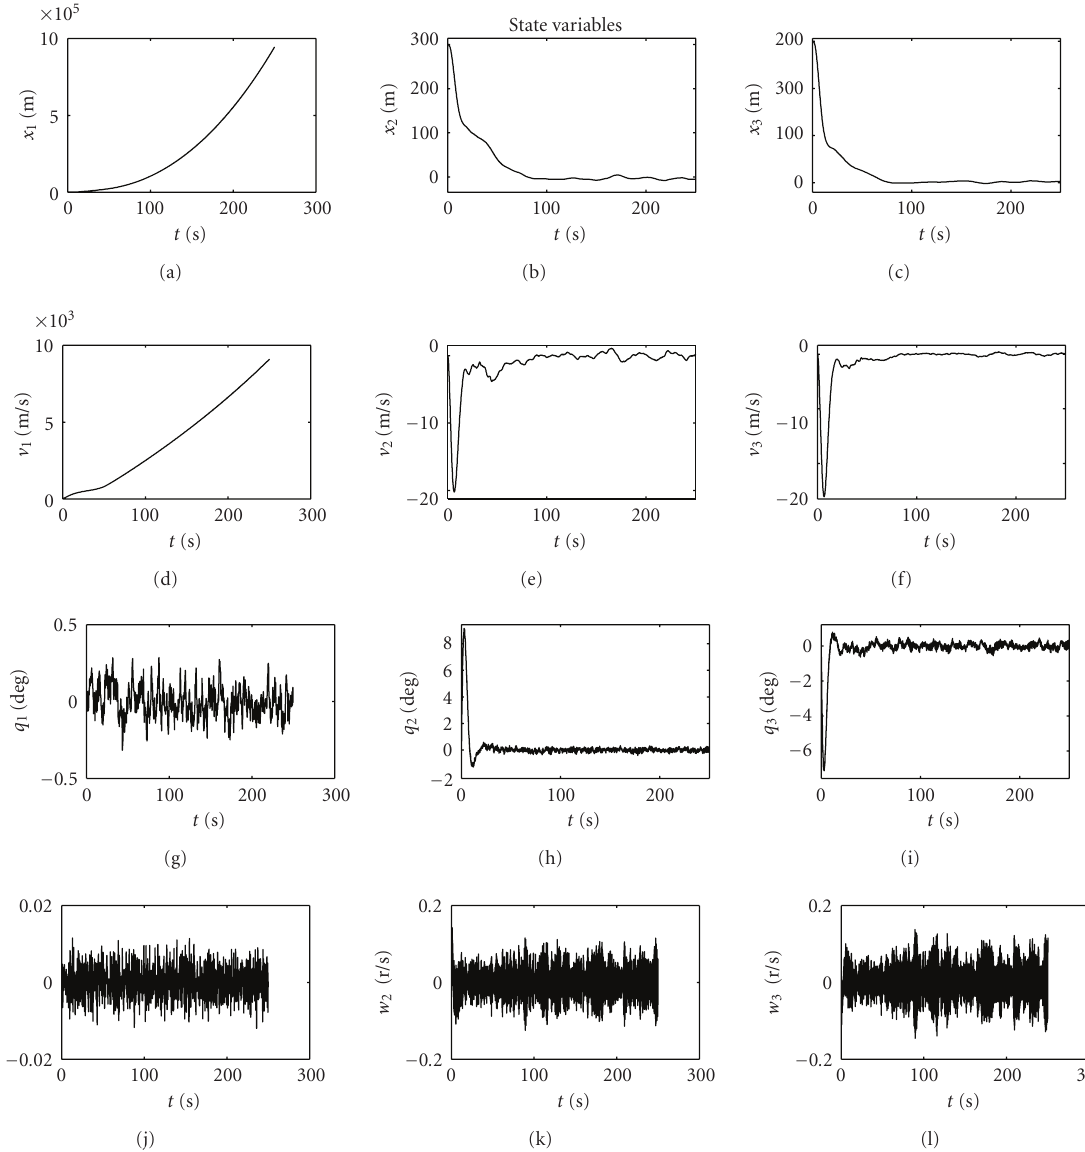
Figure 4: Response to initial conditions. Error State Variables versus time (sec). (a), (b), and (c): position components (m). (d), (e), and (f): velocity components (m/sec)). (g), (h), and (i): quaternion components (deg). (j), (k), and (l): angular velocity components